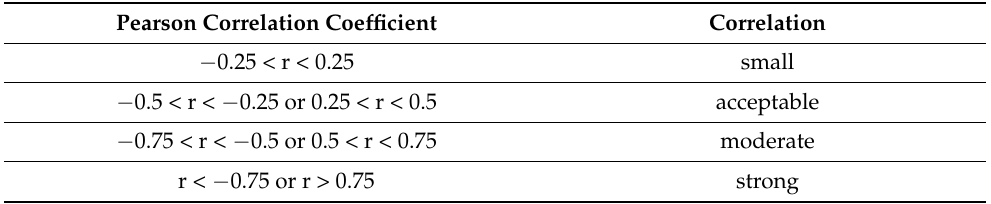
Table 3. Pearson correlation coefficient.